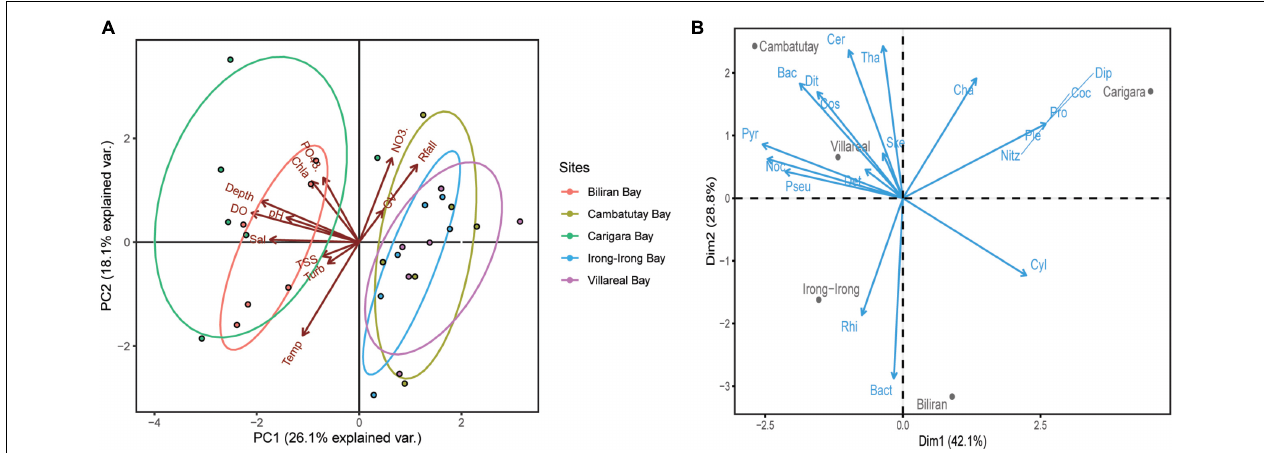
FIGURE 3 | Biplot of Principal Component Analysis (PCA). (A) PCA biplot for physico-chemical parameters of the five bays against different environmental gradients. The axis scores were shown for PCA 1 and PCA 2. There are five groups included during the PCA, represented by the five different bays designated by a specific color. Physico-chemical parameters legend: Sal (salinity), Turb (turbidity), Temp (temperature), Rfall (rainfall), CV (current velocity), TSS (total suspended solids), chla (chlorophyll-a), PO 4 − 3 (phosphate), NO 3 − (nitrate), and DO (dissolved oxygen). (B) PCA biplot of the phytoplankton abundance in five sampling sites. The blue arrows represent the phytoplankton genera. Phytoplankton legend: Ske ( Skeletonema ), Tha ( Thalassionema ), Pseu ( Pseudo-nitzschia ), Cha ( Chaetoceros ), Cos ( Coscinodiscus ), Bact ( Bacteriastrum ), Bac ( Bacillaria ), Dit ( Ditylum ), Cer ( Ceratium ), Noc ( Noctiluca ), Pyr ( Pyrodinium ), Det ( Detonula ), Rhi ( Rhizosolenia ), Cyl ( Cylindrotheca ), Ple ( Pleurosigma ), Dip ( Diploneis ), Nitz ( Nitzschia ), Coc ( Cocconeis ), and Pro ( Prorocentrum